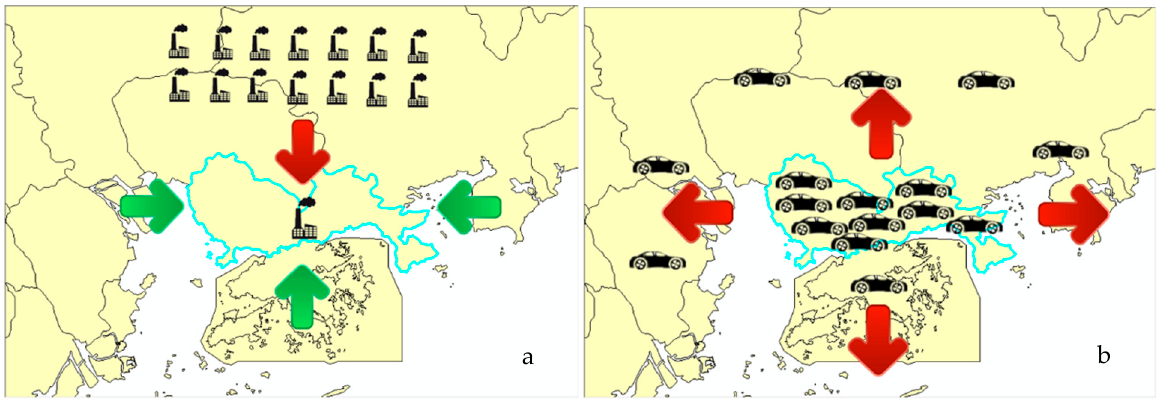
Figure 5. Relationship between wind direction and pollution in Shenzhen. a : Except for NO 2 , the concentration of all pollutants increases with the north wind; b : The concentration of NO 2 decreases with the wind in all directions.